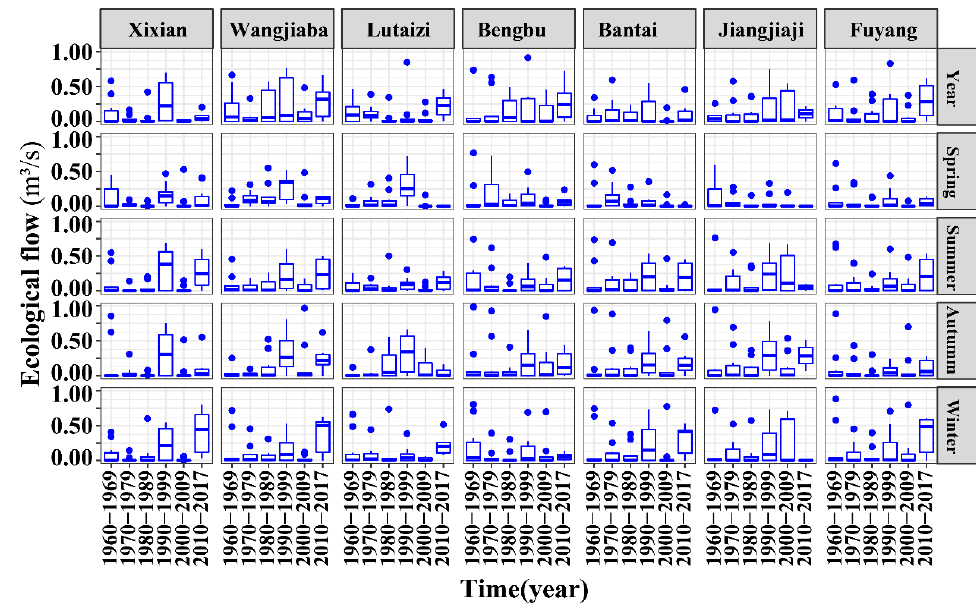
Figure 7. Change of the eco-surplus on the annual and seasonal scale.